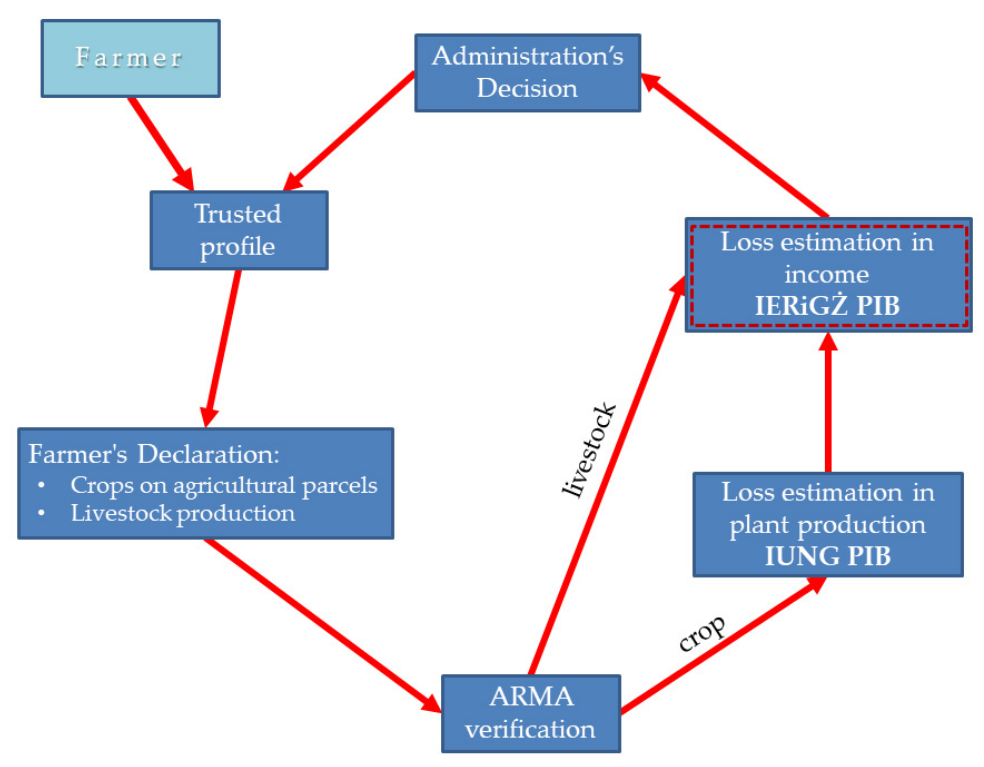
Figure 1. Scheme of information flow in the Government Drought Application. Source: own elaboration (IUNG-PIB).